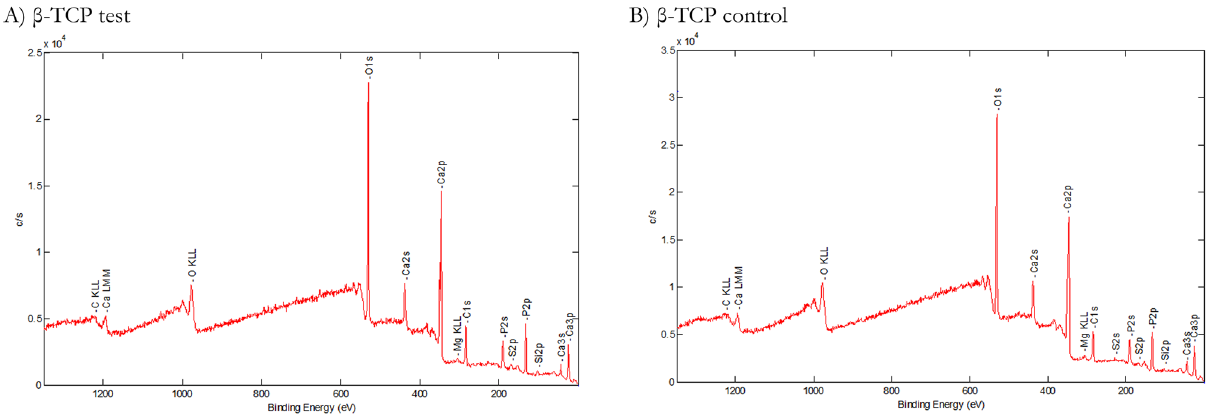
Figure 3. XPS spectra were used to determine the atomic compositions (%). β-TCP test ( A ) and β-TCP control ( B ) specimens show Ca, P, and O. Small amounts of contaminants such as C were present in both β-TCP